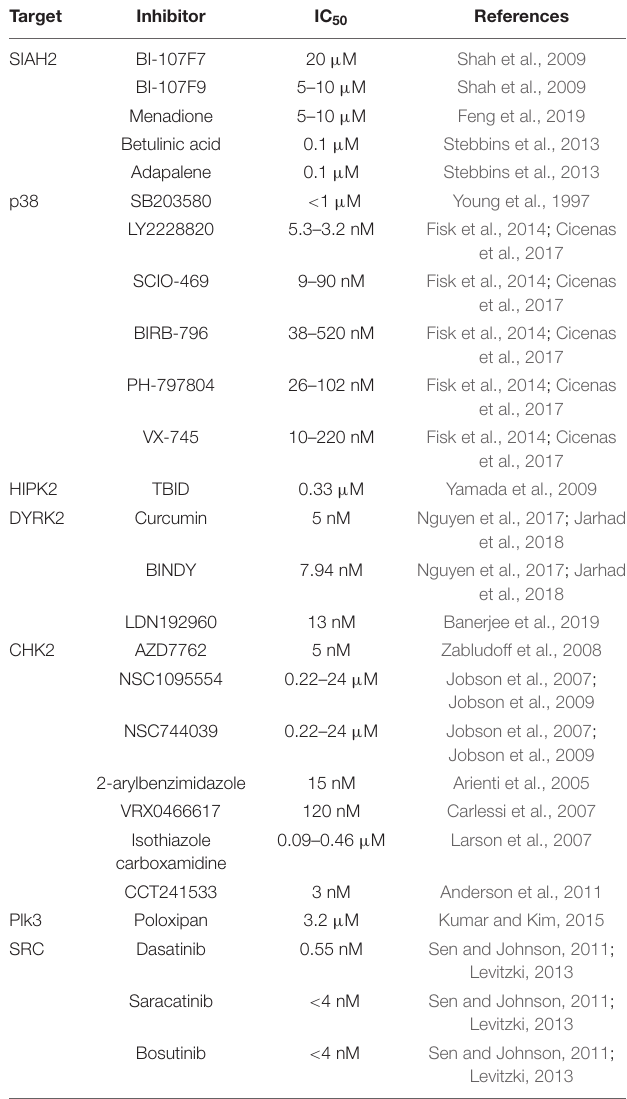
TABLE 2 | Representative inhibitors of SIAH2 and protein kinases that regulate SIAH2. Target Inhibitor IC